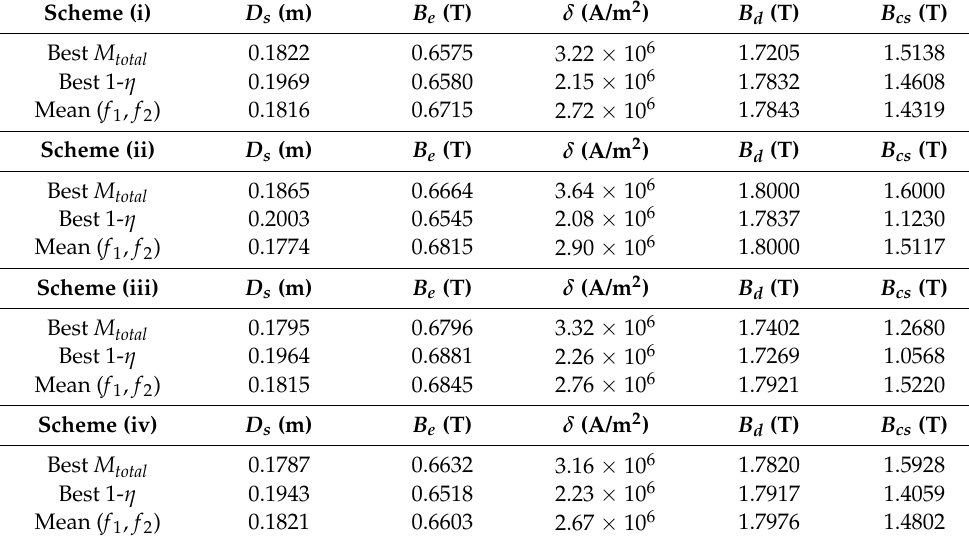
Table 4. Results in terms of decision variables for MOALO.